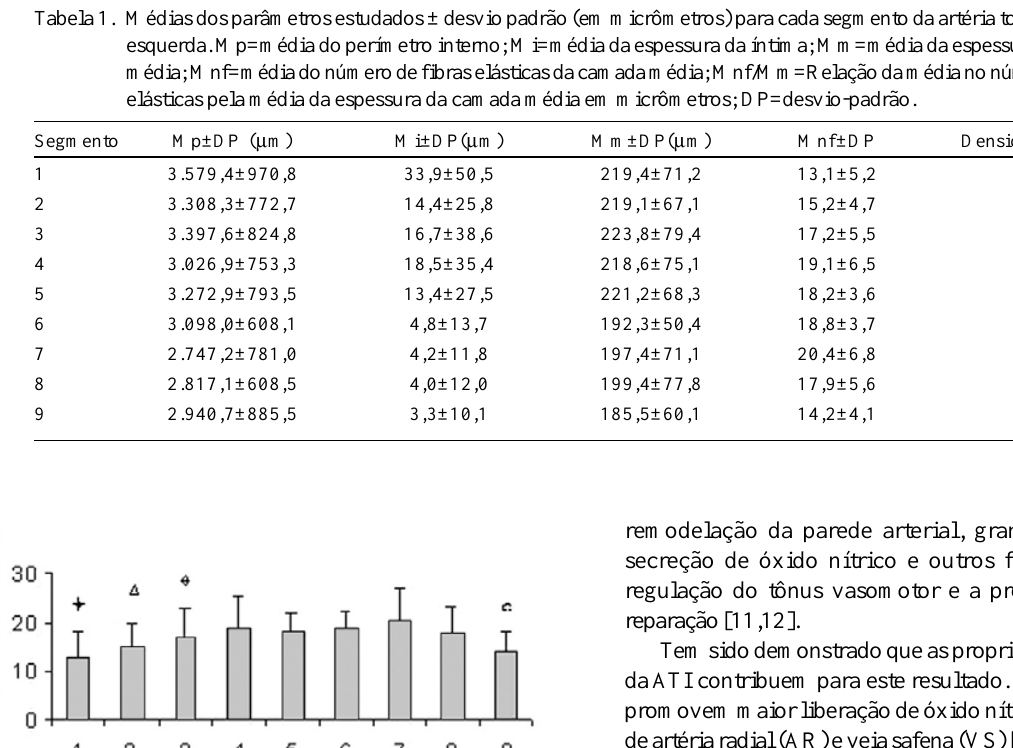
Tabela 1. Médias dos parâmetros estudados ± desvio padrão (em micrômetros) para cada segmento da artéria torácica